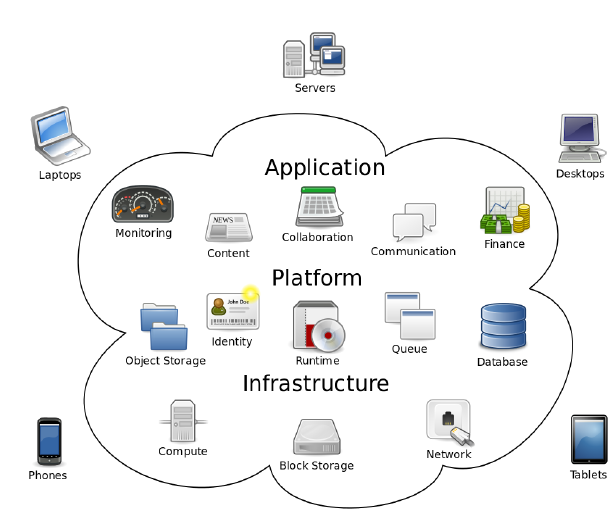
Figure 1. Cloud Computing Architectural Framework